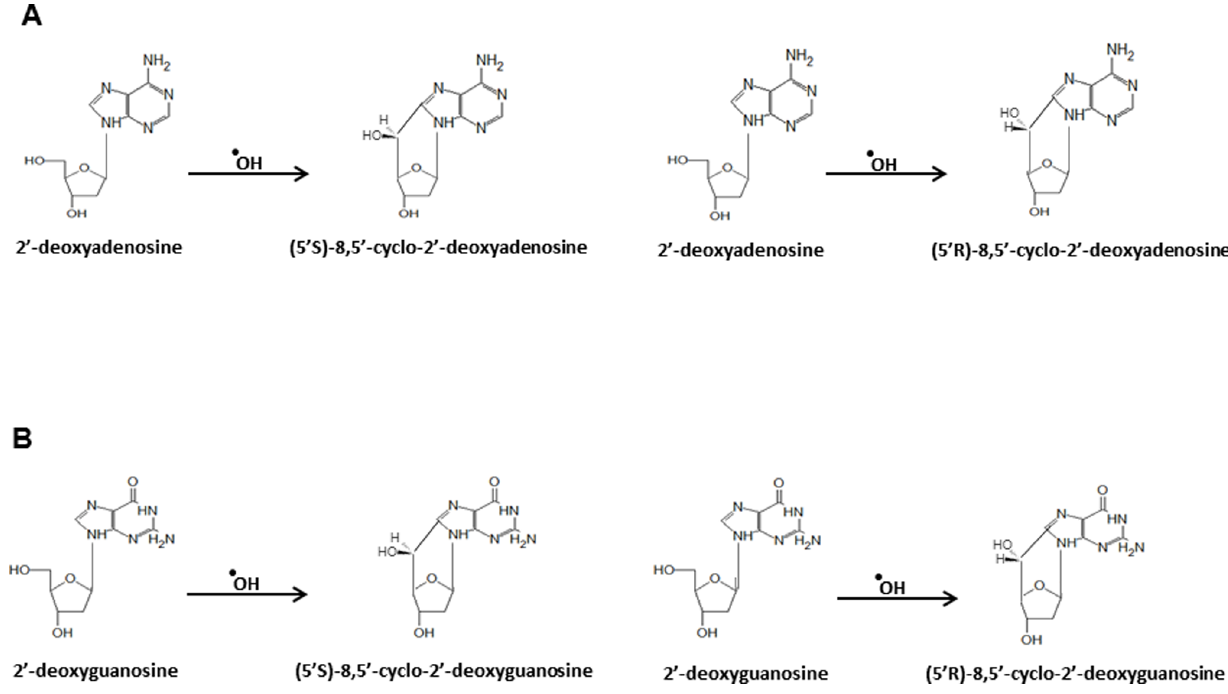
Figure 1. Conversion of adenine and guanine bases to cyclo dA and cyclo dG bases. A, Formation of 2 9 -deoxyadenosine to (5 9 S) 8,5 9 -cyclo- 2 9 -dA and (5 9 R) 8,5 9 -cyclo-2 9 -dA. B, Formation of 2 9 -deoxyguanosine to (5 9 S) 8,5 9 -cyclo-2 9 -dG and (5 9 R) 8,5 9 -cyclo-2 9 -dG. doi:10.1371/journal.pone.0113293.g001 PLOS ONE |